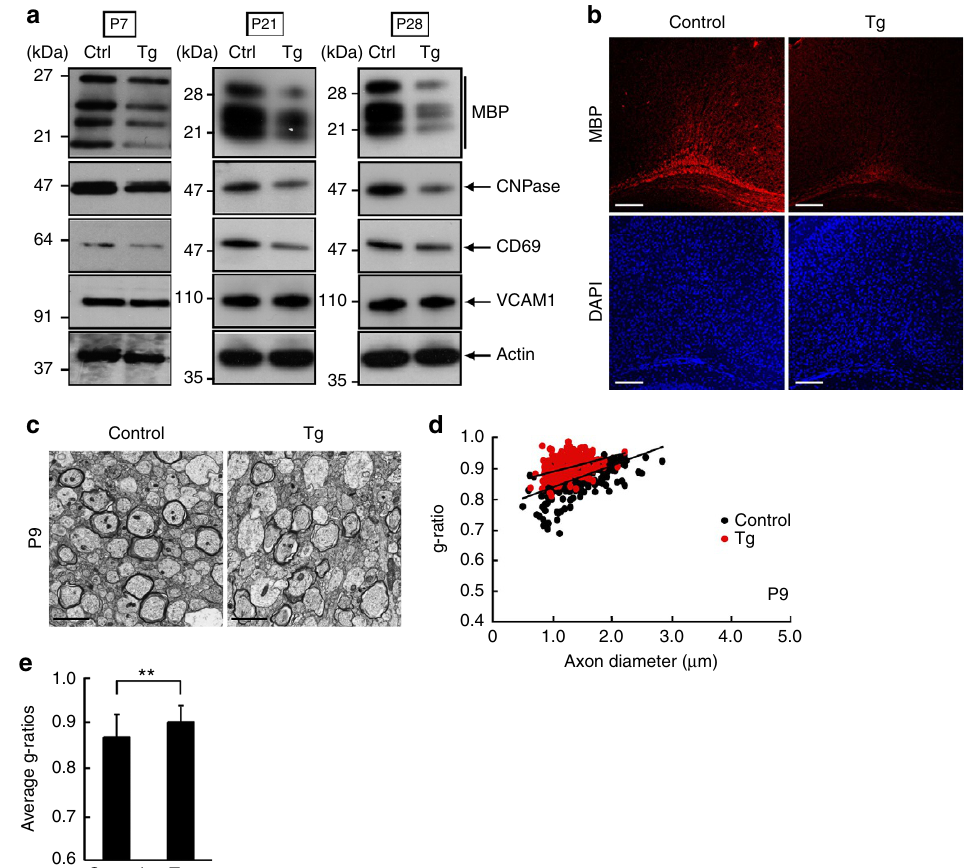
Figure 7 | CD69 is also involved in the initiation of myelination. ( a ) Tissue lysates from 7-, 21- and 28-day-old CD69 shRNA transgenic (Tg) and control mouse brains were immunoblotted with an antibody against MBP, CNPase, CD69, VCAM1 or actin. Data are representative of three experiments. ( b ) Corpus callosum sections at postnatal day 11 were co-stained with an anti-MBP antibody (red) and DAPI (blue). Data are representative of two experiments. Scale bar, 200 m m. ( c – e ) Electron microscopic data of 9-day-old corpus callosum are shown. Data are representative. Scale bar, 2 m m. The g-ratios (200–300 myelinated fibres) are plotted for axon diameters. Average g-ratios are also shown. Data were evaluated using Student’s t -test (** P ¼ 7.13E (cid:2) 15; n ¼ 213–260 axons of two independent experiments). NATURE COMMUNICATIONS|7:13478|DOI: